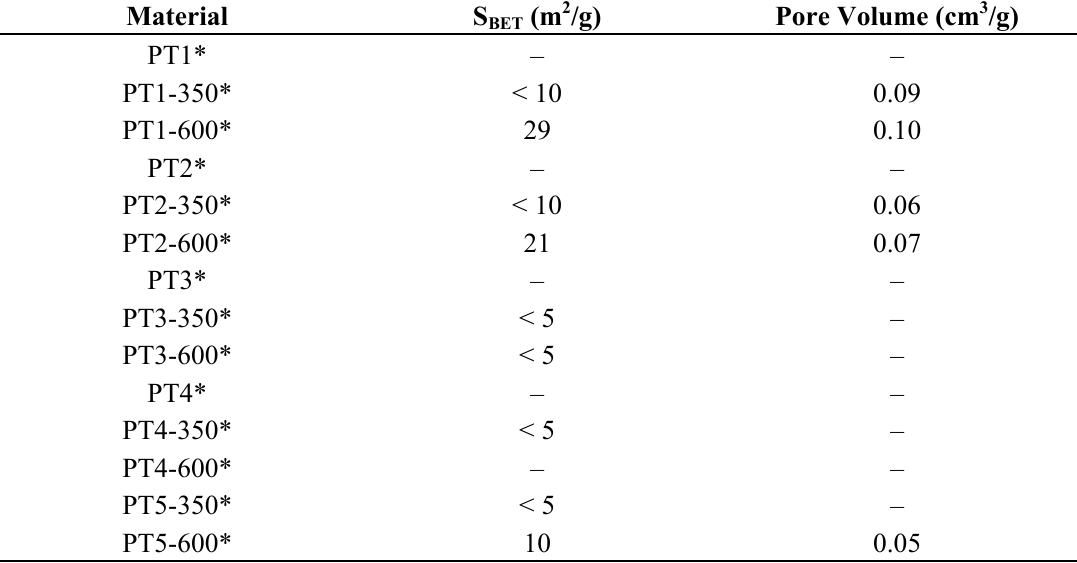
Table 1. Porosity properties of carbonized materials investigated in this